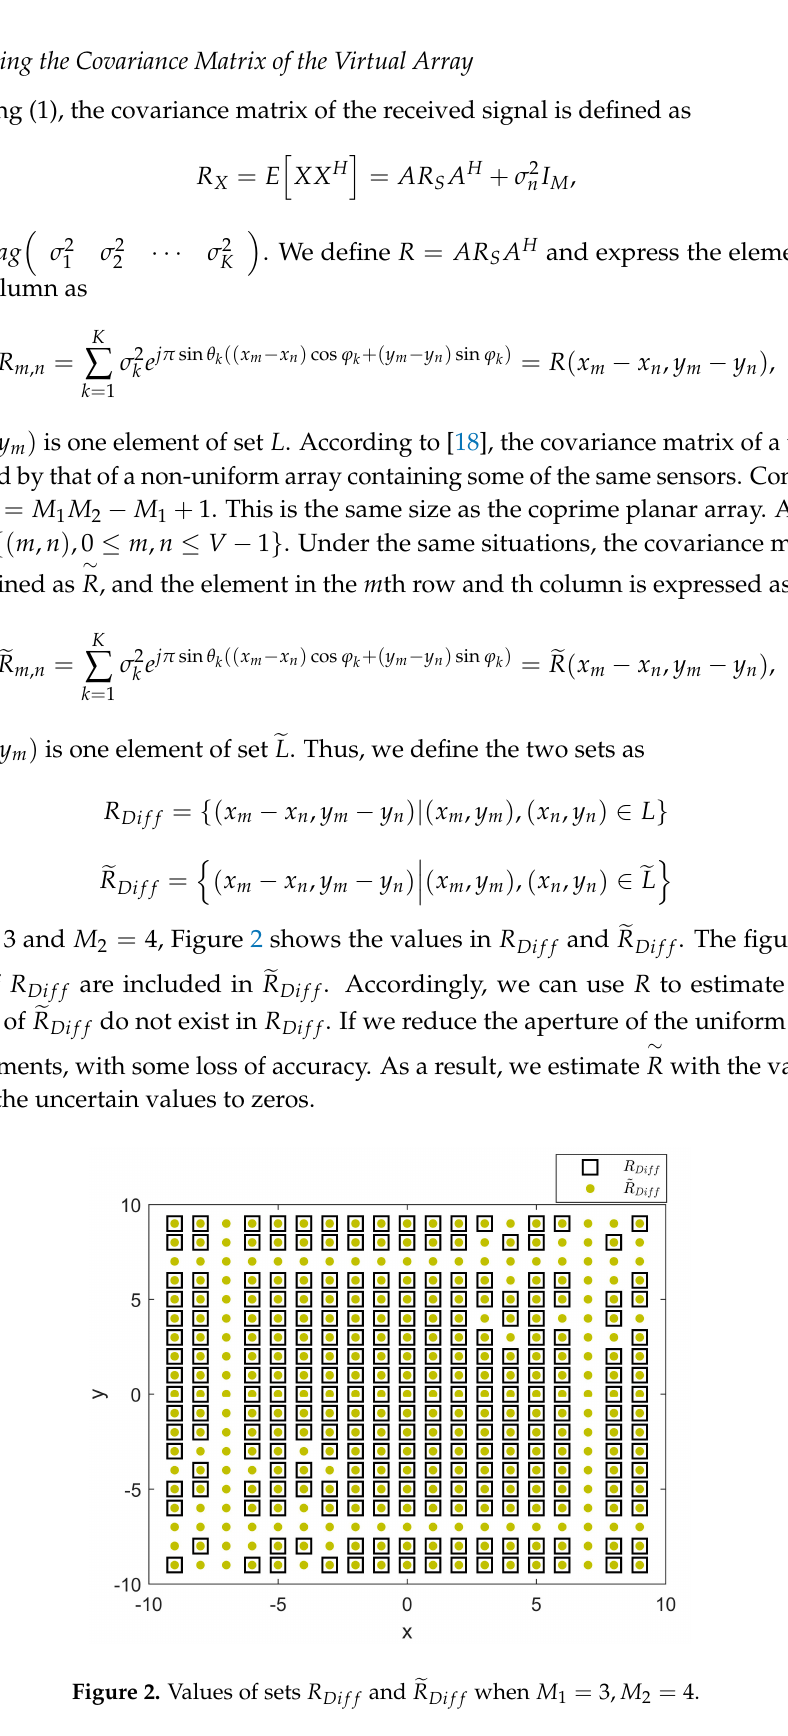
Figure 2. Values of sets R Dif f and (cid:101) R Dif f when M 1 = 3, M 2 =